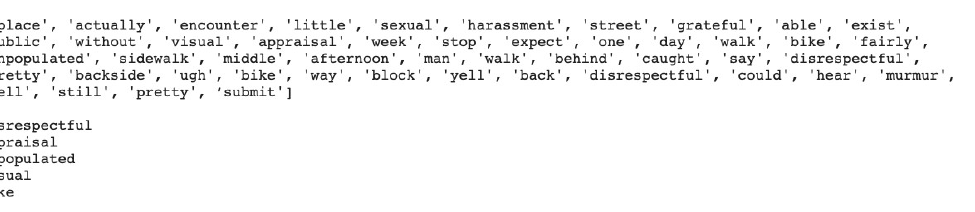
Figure 14. TF-IDF results.